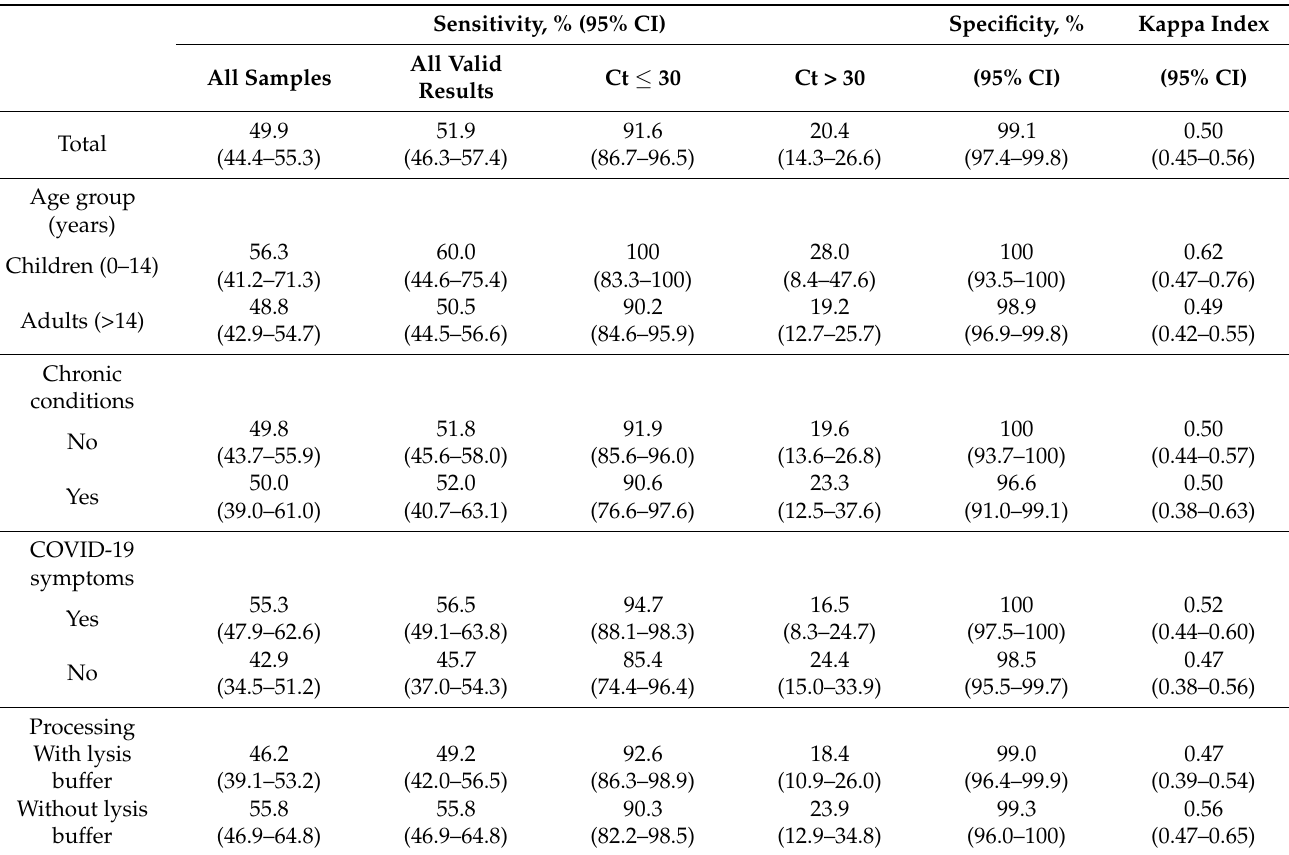
Table 2. Sensitivity (according to Ct and total), specificity, and kappa index of the saliva samples as compared with the result of nasopharyngeal